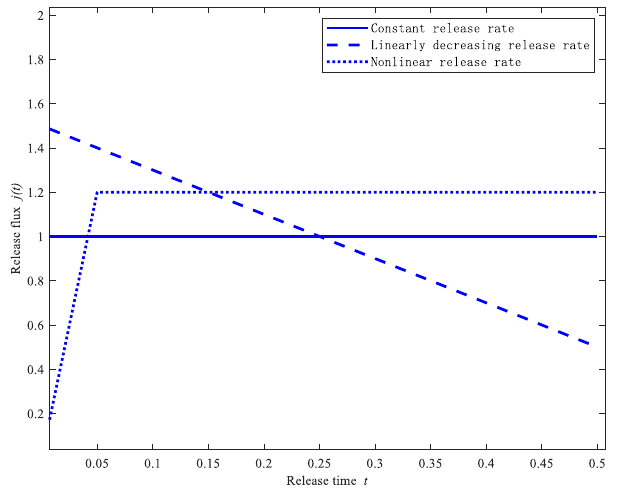
Figure 3. Three desired release profiles.